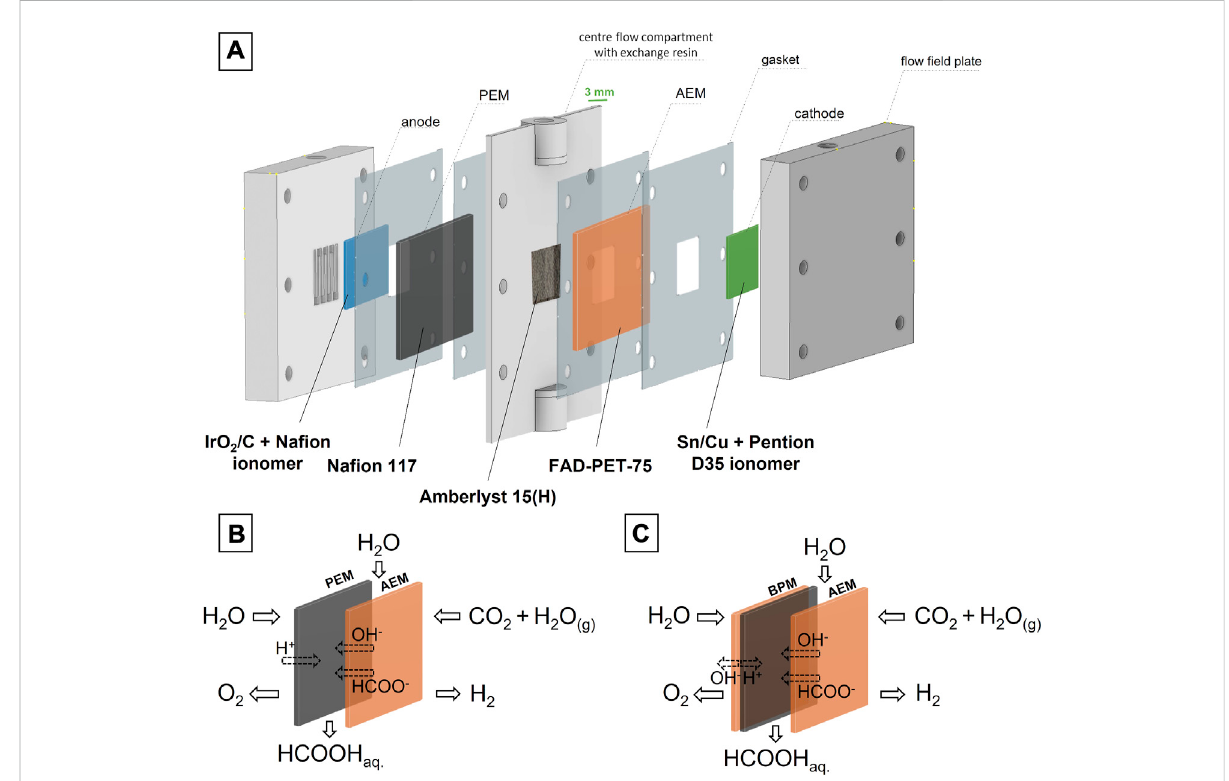
FIGURE 3 Con fi guration of the three compartment formic acid electrolyser (A) and membrane con fi guration for an electrolyser with IrO 2 /C anode (B) or NiFe anode (C) , showing the mobility of the ions as well as the feedstock and main product